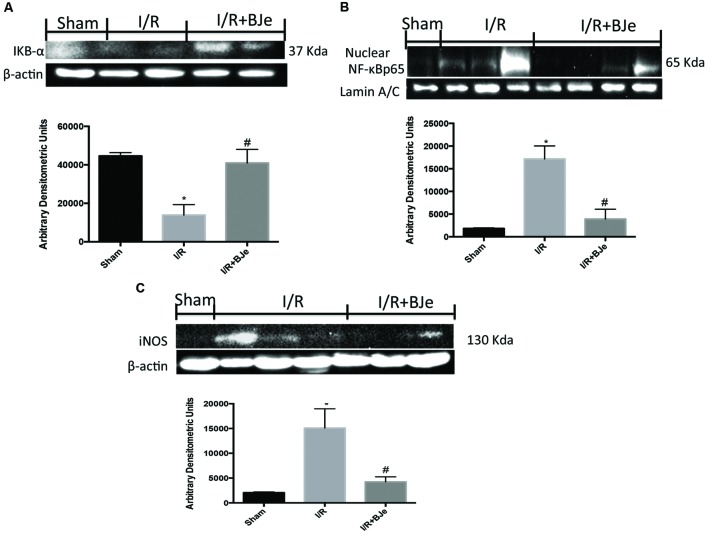
Effect of BJe on NF-κB pathway. Representative western blots showing the effects of BJe on IκB-α degradation (A), NF-κB p65 translocation (B) and iNOS expression (C) after SAO shock. BJe treatment reduced IκB-α degradation (A), NF-κB p65 translocation (B) and iNOS expression (C). A representative blot of lysates (A,B) obtained from 10 animals/group is shown, and densitometry analysis of all animals is reported. The results in (A–C) are expressed as means ± SEM of 10 mice for each group. ∗P < 0.05 vs. SHAM; #P < 0.05 vs. I/R.